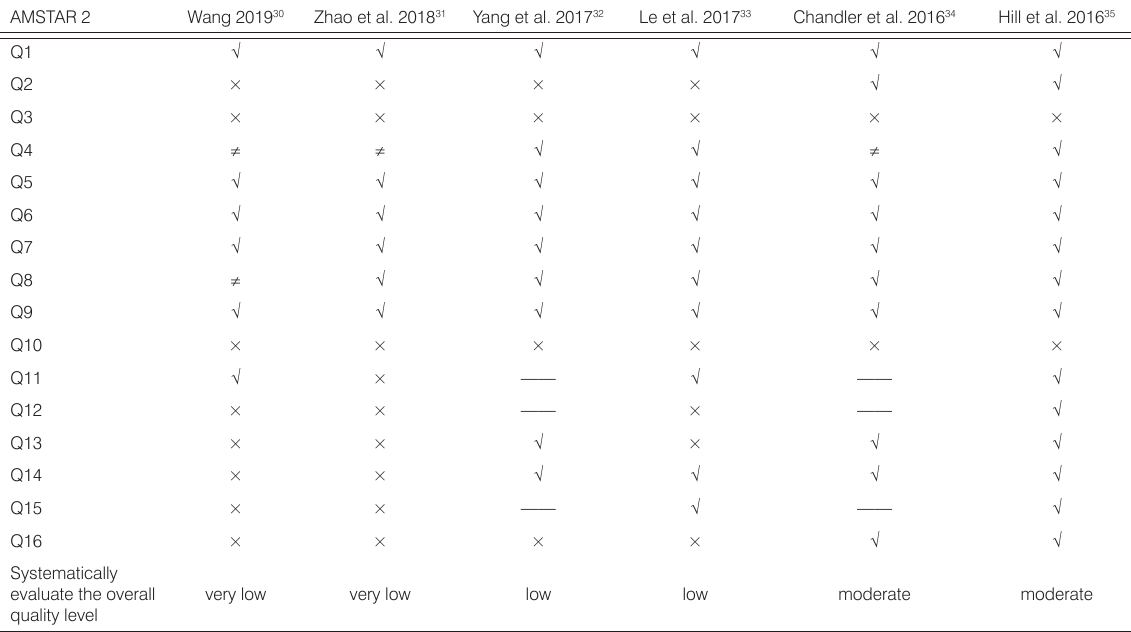
Systematically evaluate the overall